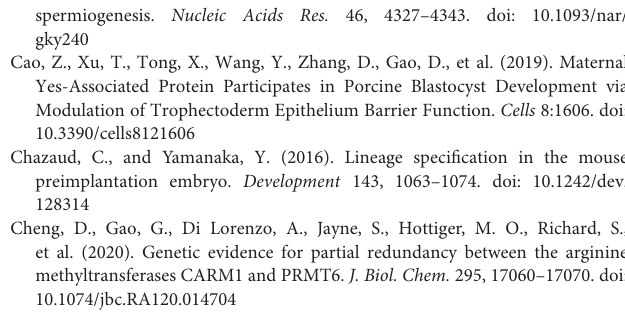
Supplementary Figure 1 | Verification of the specificity of H3R2me2, H3R17me2, and H3R26me2 antibody. H3R2me2, H3R17me2, and H3R26me2 antibody was tested on porcine blastocysts. The secondary antibody was replaced with blocking buffer to serve as a negative control. Representative images obtained by confocal microscopy are shown. Scale bar: 50 µ m. Supplementary Figure 2 | Effect of CARM1 inhibition on cleavage-stage embryonic development, H3R2me2, and H3R17me2 levels in embryos. (A) Representative images of embryos at different stages. Scale bar: 100 µ m. (B) Developmental rates of 2-cell, 4-cell, 8-cell, and morula in the control and the CARM1 inhibition groups. Effect of CARM1 inhibition on H3R2me2 (C) and H3R17me2 (D) levels in 2-cell, 4-cell, and blastocysts. Embryos at different stages were stained for H3R2me2, H3R17me2 (red), and DNA (blue). The experiment was independently repeated three times with at least 15 embryos per group. Scale bar: 50 µ m. All data are shown as mean ± S.E.M and different letters on the bars indicate significant differences ( P < 0.05). Supplementary Figure 3 | Effect of CARM1 knockdown on H3R2me2 and H3R17me2 levels in embryos, and cleavage-stage embryonic development. Effect of CARM1 KD on H3R2me2 (A) and H3R17me2 (B) levels in 2-cell, 4-cell, and blastocysts. Embryos at different stages were stained for H3R2me2, H3R17me2 (red), and DNA (blue). The experiment was independently repeated three times with at least 11 embryos per group. Scale bar: 50 µ m. (C) Representative images of embryos at different stages. Scale bar: 100 µ m. (D) Developmental rates of 2-cell, 4-cell, 8-cell, and morula in the control and the CARM1 KD groups. All data are expressed as mean ± S.E.M and different letters on the bars indicate significant differences ( P < 0.05). Supplementary Figure 4 | Effect of CARM1 knockdown on blastocyst formation and lineage allocation of in vitro fertilized embryos. (A) Representative images of IVF blastocysts from different stages at days 5, 6, and 7. Scale bar: 100 µ m. (B) Percentage of blastocyst rates at days 5, 6, and 7. (C) Representative fluorescence images of IVF blastocysts. Embryos at different groups were stained for CDX2 (green) and DNA (blue). The experiment was independently repeated three times with at least 20 embryos per group. Scale bar: 50 µ m. (D) Analysis of lineage allocation in IVF blastocysts. The numbers of total cells, ICM cells, TE cells, and the ratio of ICM cells to TE cells were recorded and subject to statistical analysis. ICM: inner cell mass; TE: trophectoderm. All data are expressed as mean ± S.E.M and different letters on the bars indicate significant differences ( P < 0.05). Supplementary Figure 5 | Validation of single-embryo RNA sequencing data by qPCR. Relative abundance of six differentially expressed genes was determined by qPCR. The experiment was independently repeated three times. Data were normalized to the housekeeping gene ( EF1 α 1 ) and the data from control group were set as 1. Data are shown as mean ± S.E.M and different letters on the bars indicate significant differences ( P <